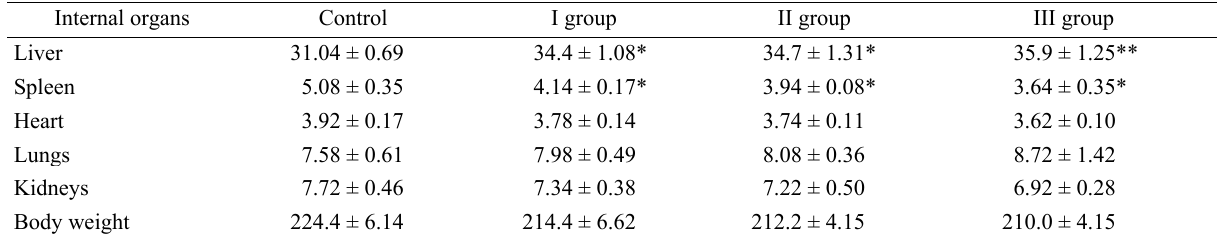
Weight coefficients of the mass of internal organs of white rats (M ± m, n = 5) Internal organs